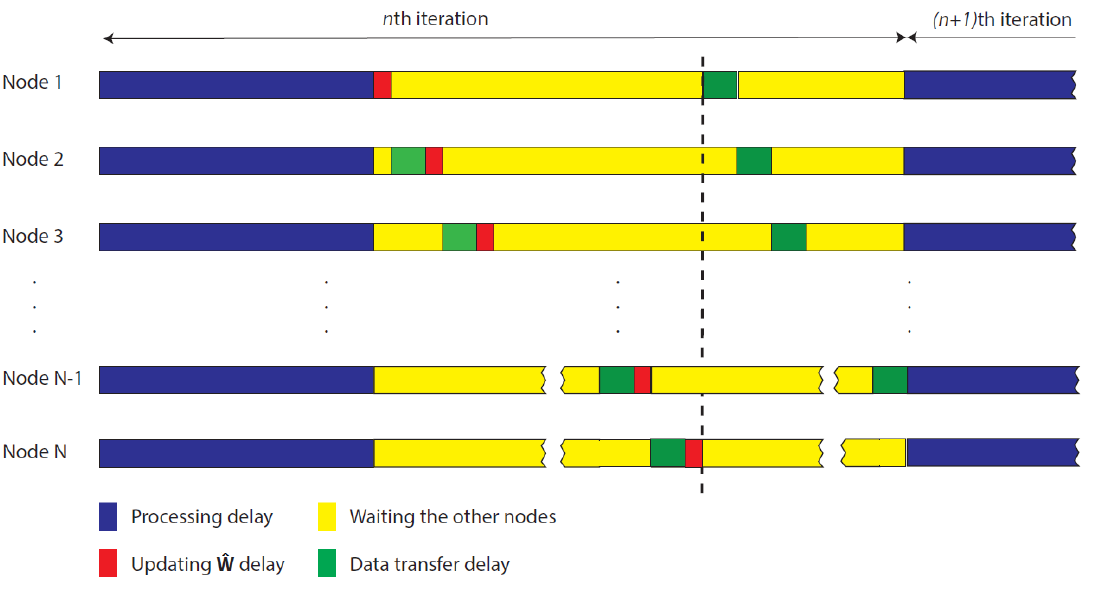
Figure 6. Timing diagram of the processes carried out by each node of the network at each block